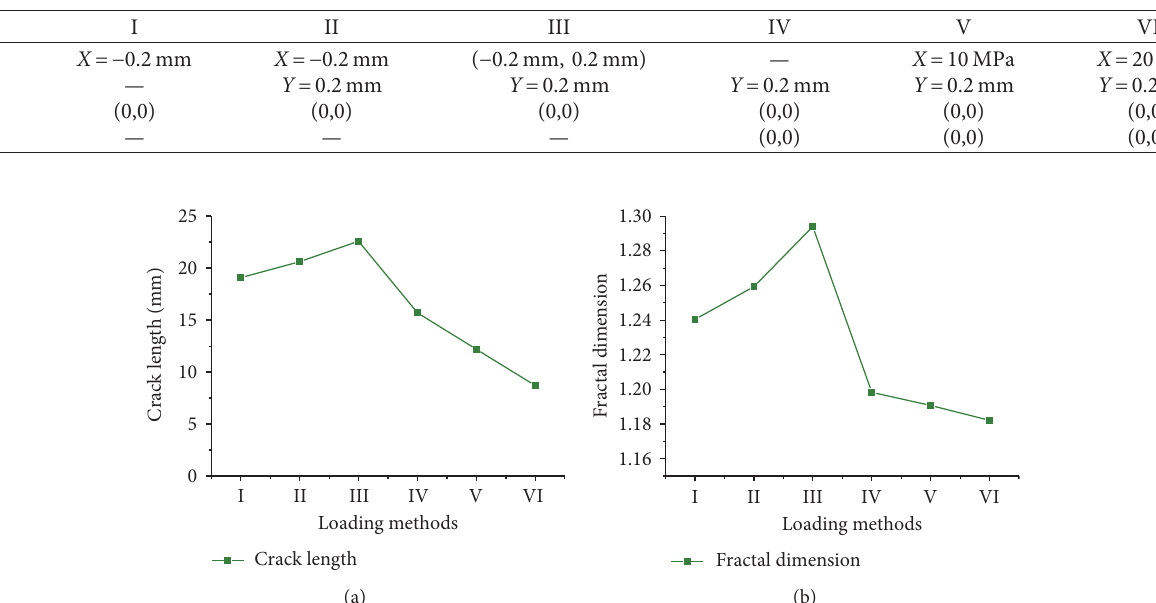
Figure 3: Six different loading methods. (a) Loading method I: a displacement load of X � -0.2 mm is applied to the left boundary L and the right boundary R is fixed. (b) Loading method II: a displacement load of X � − 0.2mm is applied to the left boundary L; a displacement load of Y � 0.2 mm is applied to the lower left boundary LD, and the right boundary R is fixed. (c) Loading method III: the left boundary L is applied with X � 0.2 mm, Y � 0.2mm displacement load, the left lower boundary LD is applied with Y � 0.2mm displacement load, and the right boundary R is fixed. (d) Loading method IV: Y � 0.2 mm displacement load is applied to the lower left boundary LD, and the right boundary R and the upper right boundary RU are fixed. (e) Loading method V: a pressure load of X � 10MPa is applied to the left boundary L; a displacement load of Y � 0.2mm is applied to the lower left boundary LD, and the right boundary R and upper right boundary RU are fixed. (f) Loading method VI: the left boundary L is applied with a pressure load of X � 20MPa, the left lower boundary LD is applied with a displacement load of Y � 0.2mm, and the right boundary R and the upper right boundary RU are fixed. Table 3: Mechanical boundary conditions.